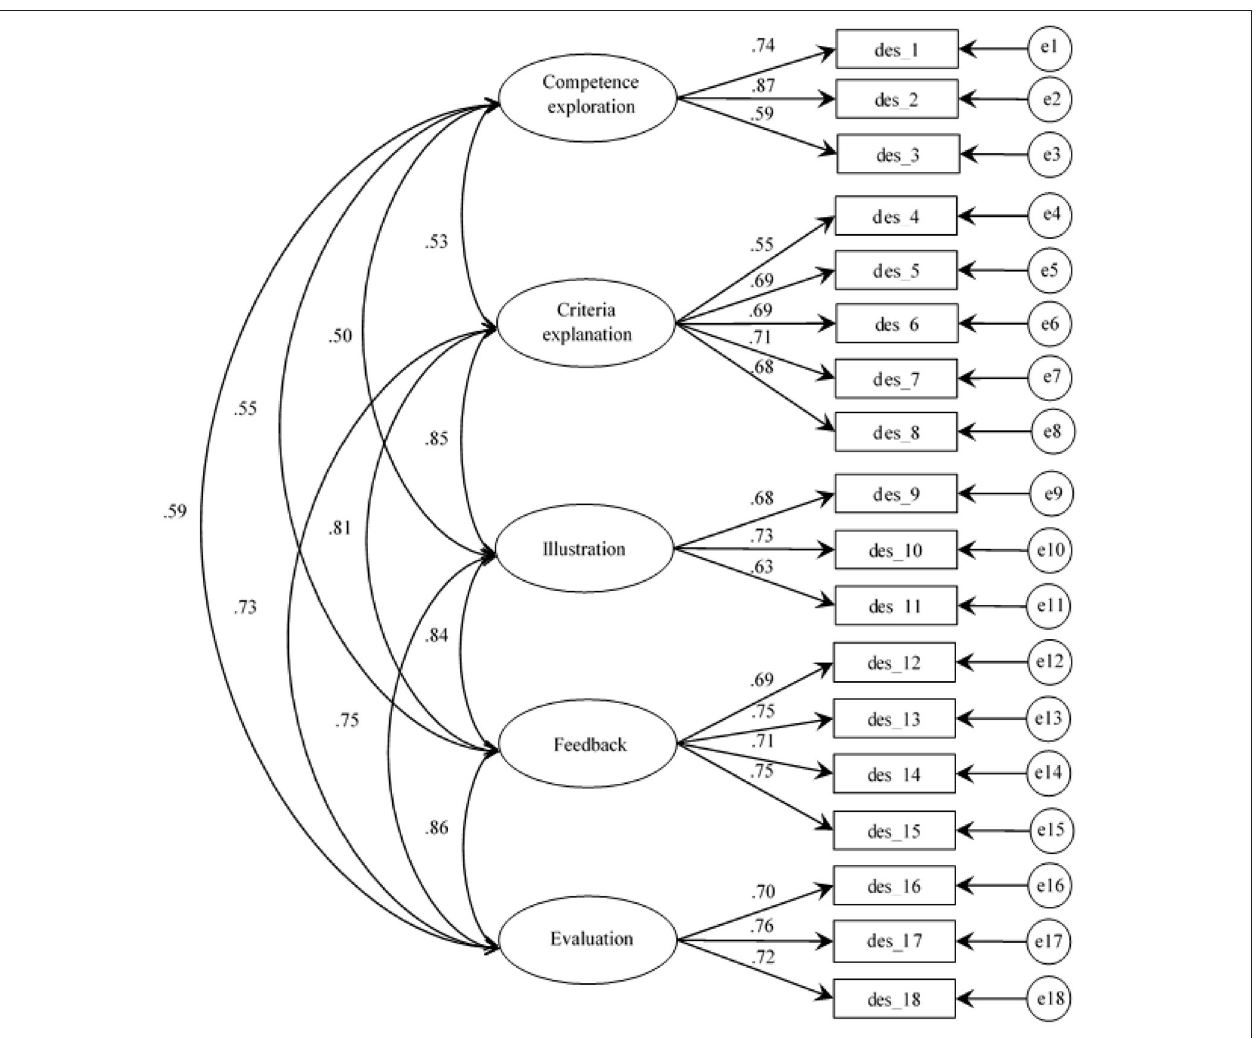
FIGURE 1 | First order CFA five-factor model of the